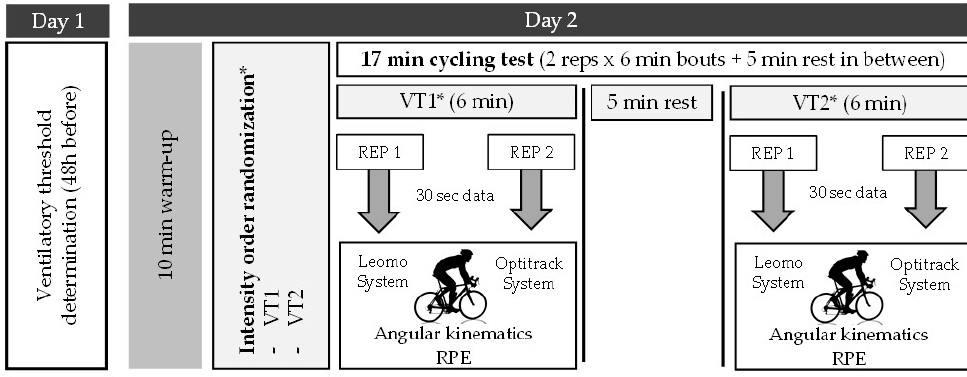
Figure 1. Study protocol procedure. * Intensity order was randomized.